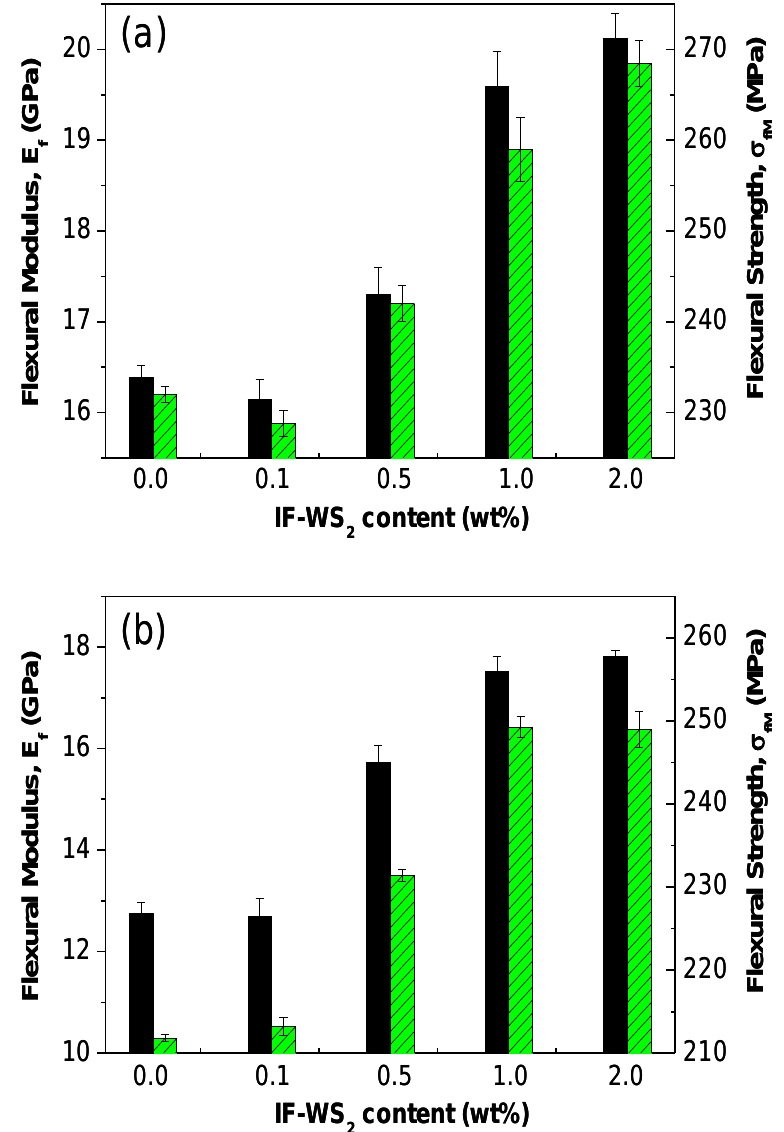
Figure 4. Flexural modulus E PPS/IF-WS /CF laminates. ( a ) 25 °C; and ( b ) 120 2